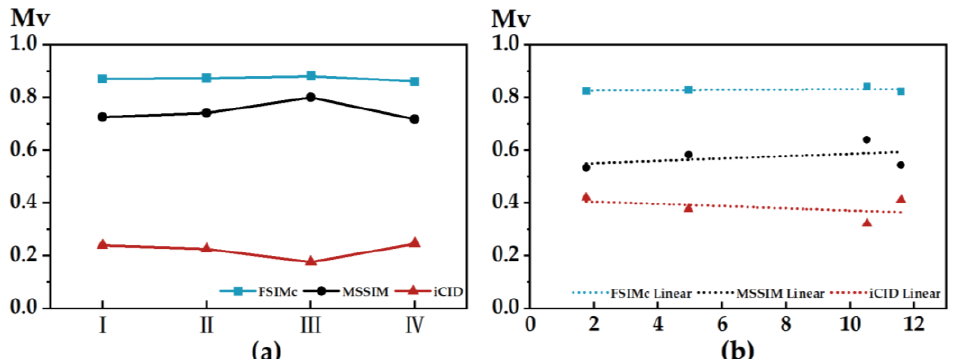
Figure 8. ( a ) Quantitative correlation of image basis metrics; ( b ) image basis metrics and chromaticity linearization.